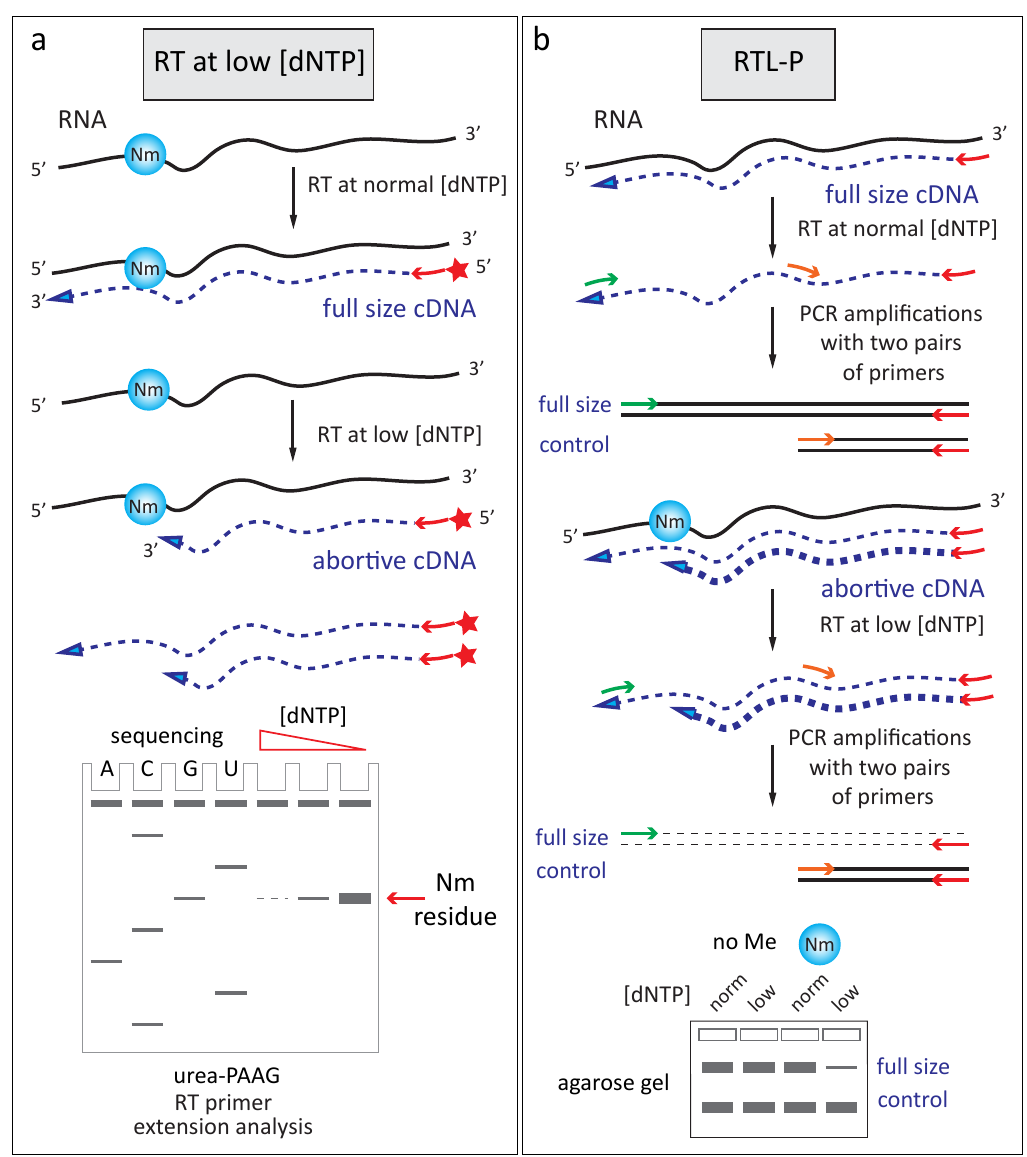
Figure 3. Analysis of 2 (cid:48) - O -methylation by reverse transcriptase (RT) stop at low [deoxynucleotide triphosphate (dNTP)]. ( a ) RT pauses at a 2 (cid:48) - O -methylated residue at low [dNTP], analysis of abortive complementary DNA (cDNA) chains is done by urea-PAAG; ( b ) Semi-quantitative PCR amplification of full-length and abortive cDNA chains obtained at normal and low